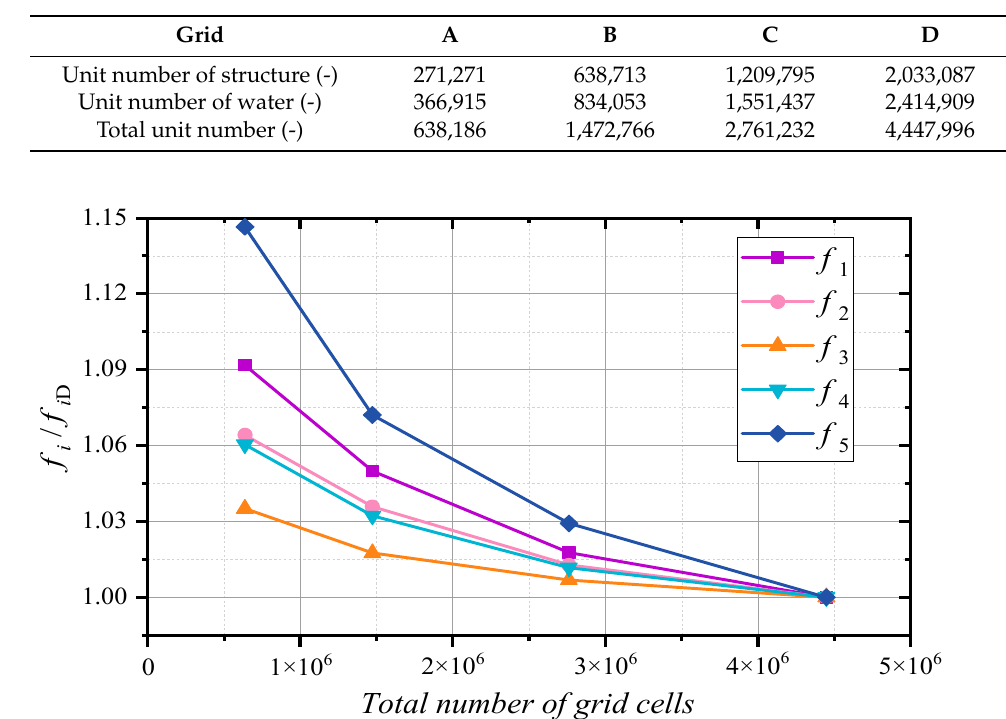
Figure 2. The first five natural frequencies of the runner in channels with different grid sizes. It can be seen that the frequencies of each order tended to a stable value with the increasing number of elements. Considering the accuracy and efficiency of the solution, grid C was selected for the simulations. The finite element model is shown in Figure